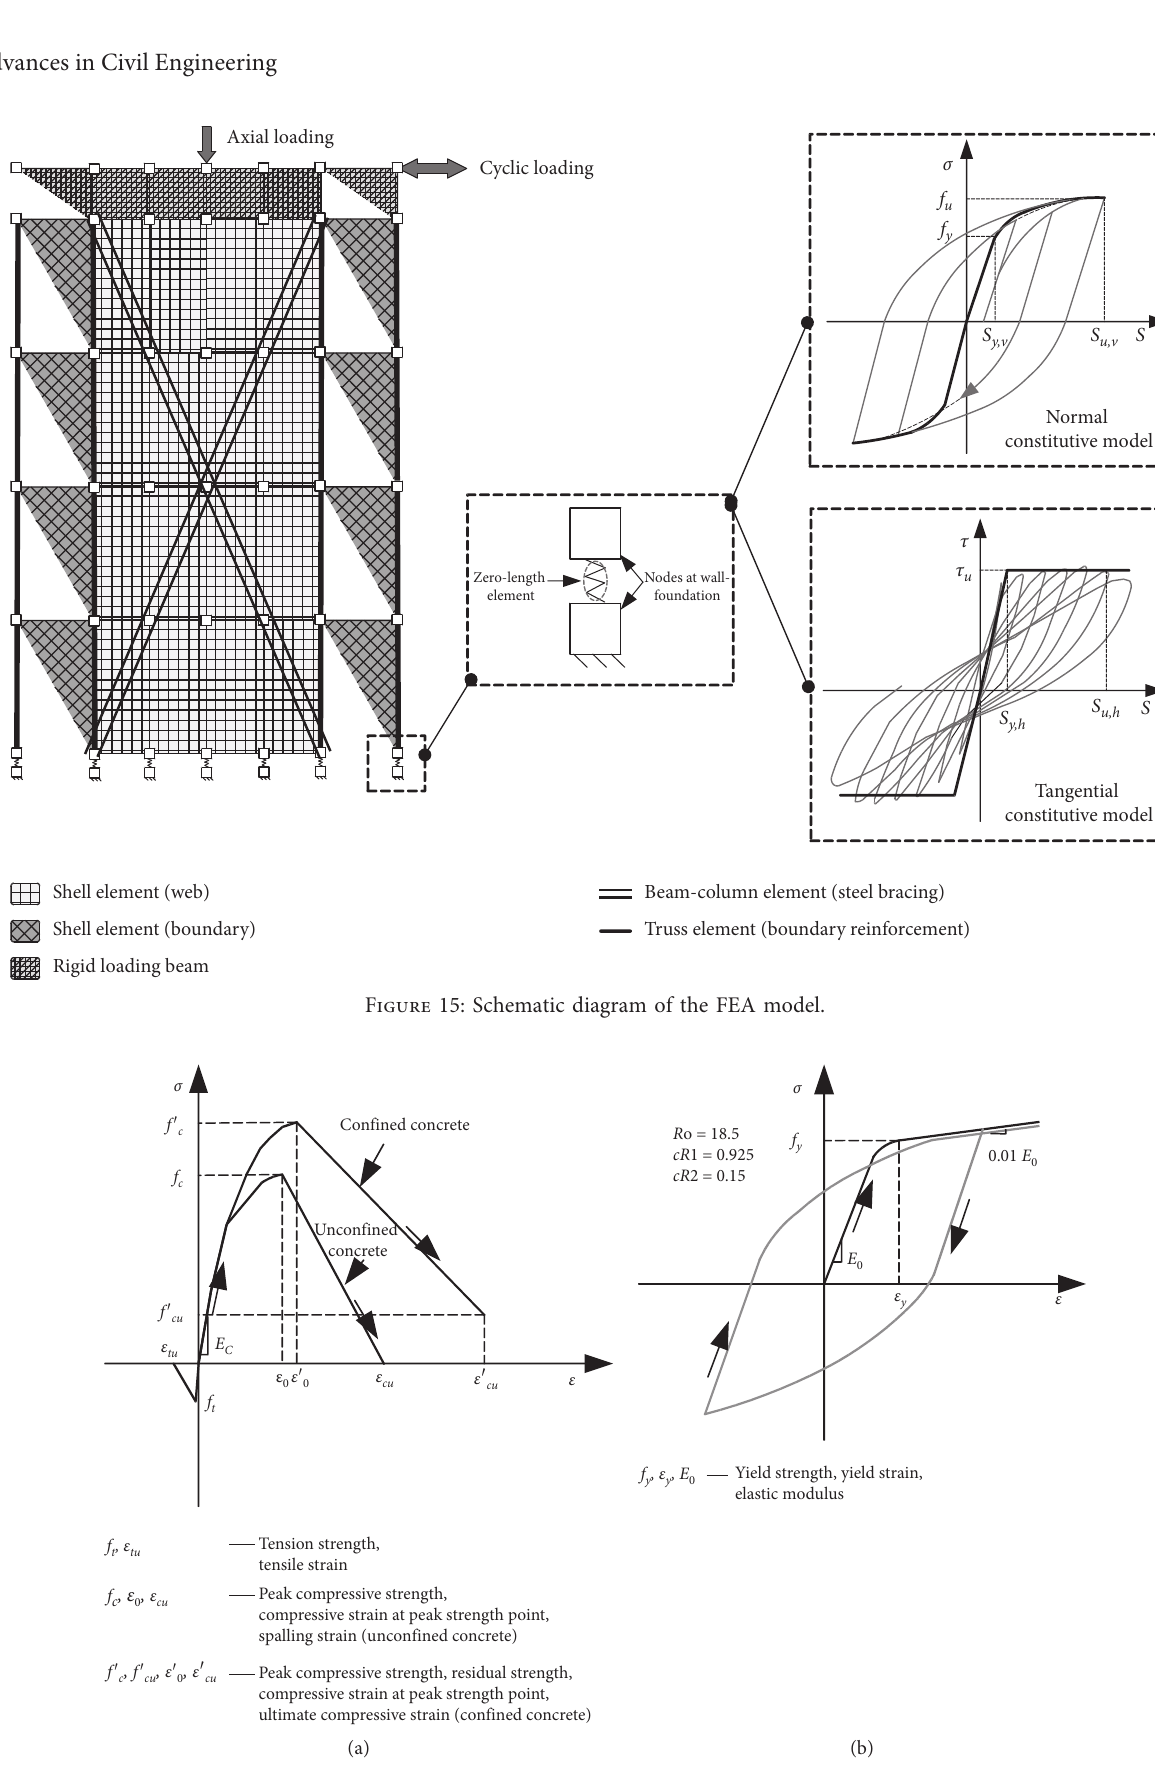
Figure 16: Stress-strain curve for materials. (a) Concrete. (b)